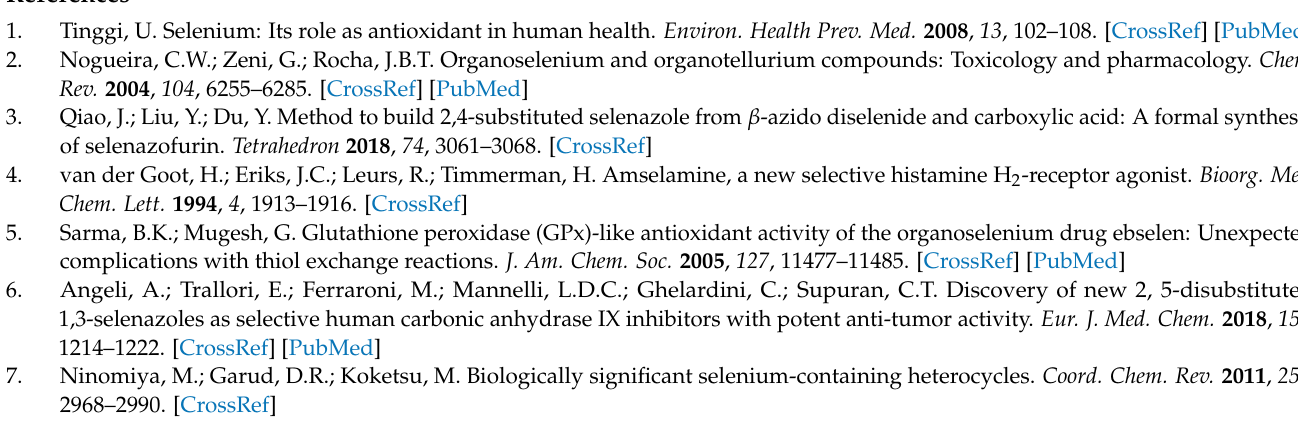
Figure S1: 1H NMR spectrum of compound 4 . Figure S2: 13C NMR spectrum of compound 4 . Figure S3: 1H-15N HSQC NMR spectrum of compound 4 . Figure S4: The overlaid 1H-13C gs-HSQC and gs-HMBC NMR spectra of compound 4 . Figure S5: 1H-15N HMBC NMR spectrum of compound 4 . Figure S6: 1H-13C 2 Hz LR-HSQMBC NMR spectra of compound 4 . Figure S7: The overlaid 1 H- 13 C gs-HSQC (red) and 60 Hz 1,1-ADEQUATE (black) NMR spectra of compound 4 . Figure S8: 77Se NMR spectrum of compound 4 . Figure S9: IR spectrum of compound 4 . Figure S10: HRMS spectrum of compound 4